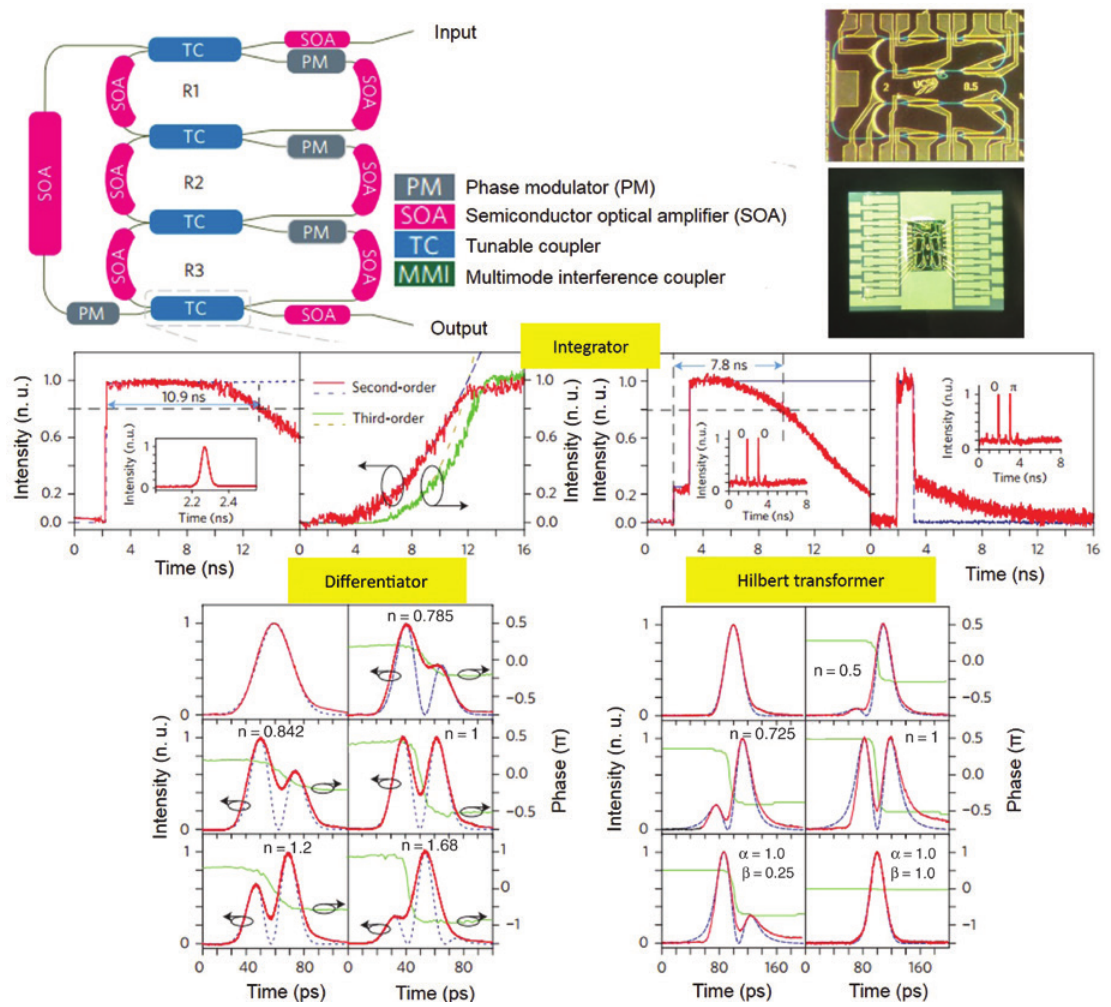
Figure 19: A reconfigurable photonic signal processor in InP [96] (Copyright in 2016, Nature